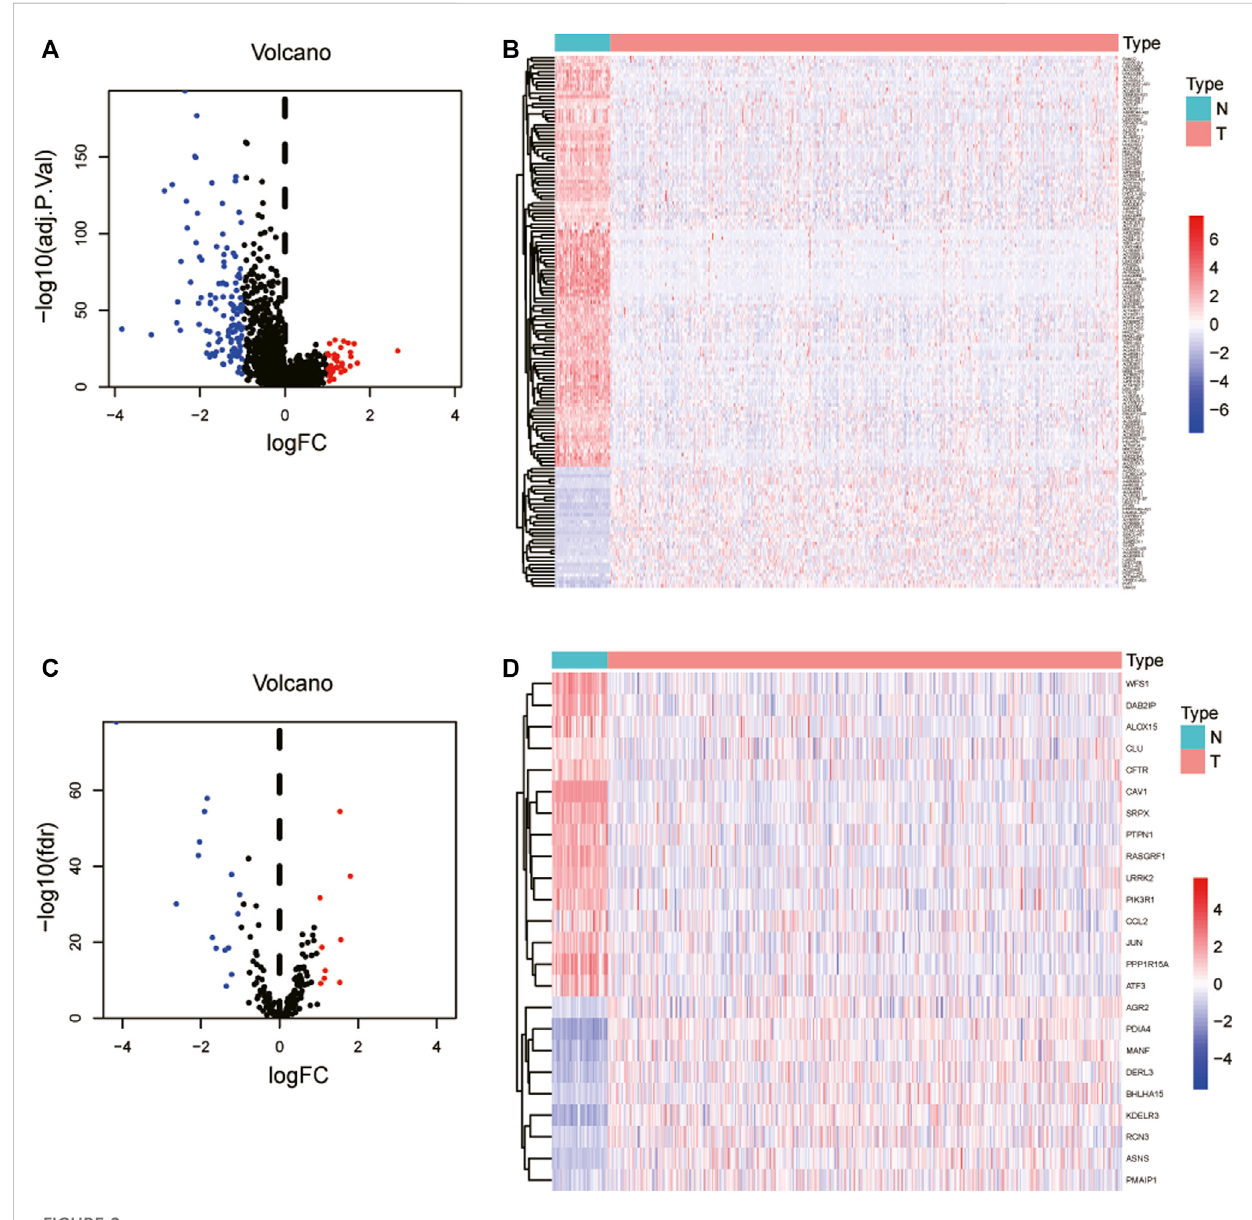
FIGURE 2 Identi fi cation of ERS-related lncRNAs in LUAD. (A) As shown in volcano plot, the 34 lncRNAs were upregulated in tumors, while 116 were downregulated. (B) Differential expression lncRNA heatmaps in tumors and normal adjacent tissues. (C) Nine ERS-related genes were found to be upregulated in tumors, whereas 15 were found to be downregulated. (D) Heatmaps of differential expression ERS-related genes in tumors and normal adjacent tissues. LUAD: Lung adenocarcinoma; ERS: Endoplasmic reticulum